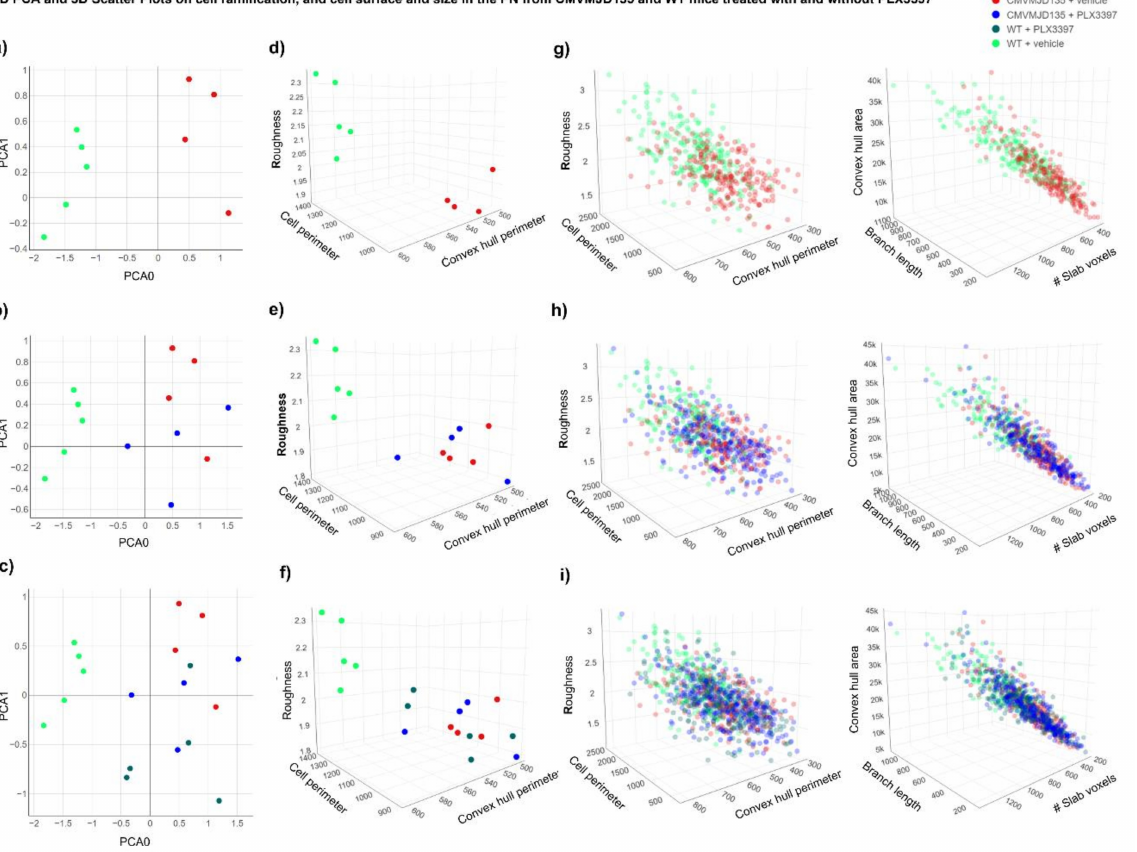
Figure 5. Separation of WT + vehicle group and all the remaining groups, including WT + PLX3397, CMVMJD135 + vehicle, and CMVMJD135 + PLX3397 mice, regarding the 16 significant morphological parameters found in the microglial cells from the PN. ( a ) 2D scatter plot showing the distribution of WT + vehicle mice (in green) and CMVMJD135 + vehicle (in red) on a principal components plane. ( b , c ) 2D scatter plots showing that the remaining groups (WT + PLX3397 and CMVMJD135 + PLX3397) were plotted closer to CMVMJD135 + vehicle mice as a function of the sixteen significant parameters found in the PN. ( d – f ) 3D scatter plots showing a separation between WT + vehicle mice and the remaining groups regarding their roughness, cell perimeter, and convex hull